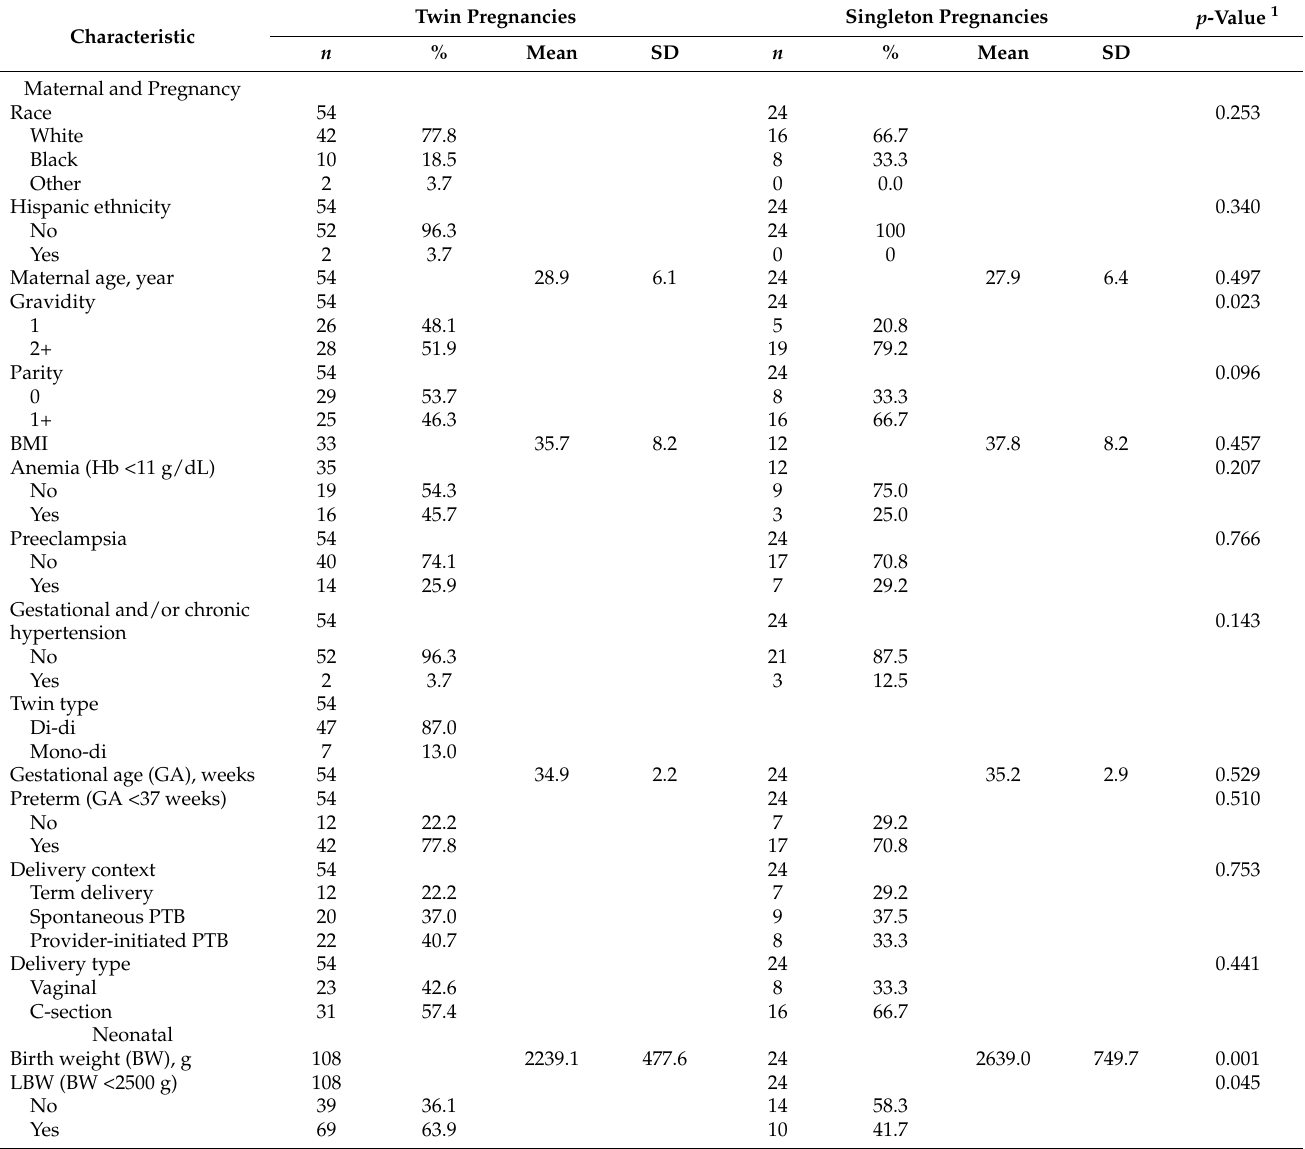
Table 1. Maternal, pregnancy and infant characteristics in sampled biorepository